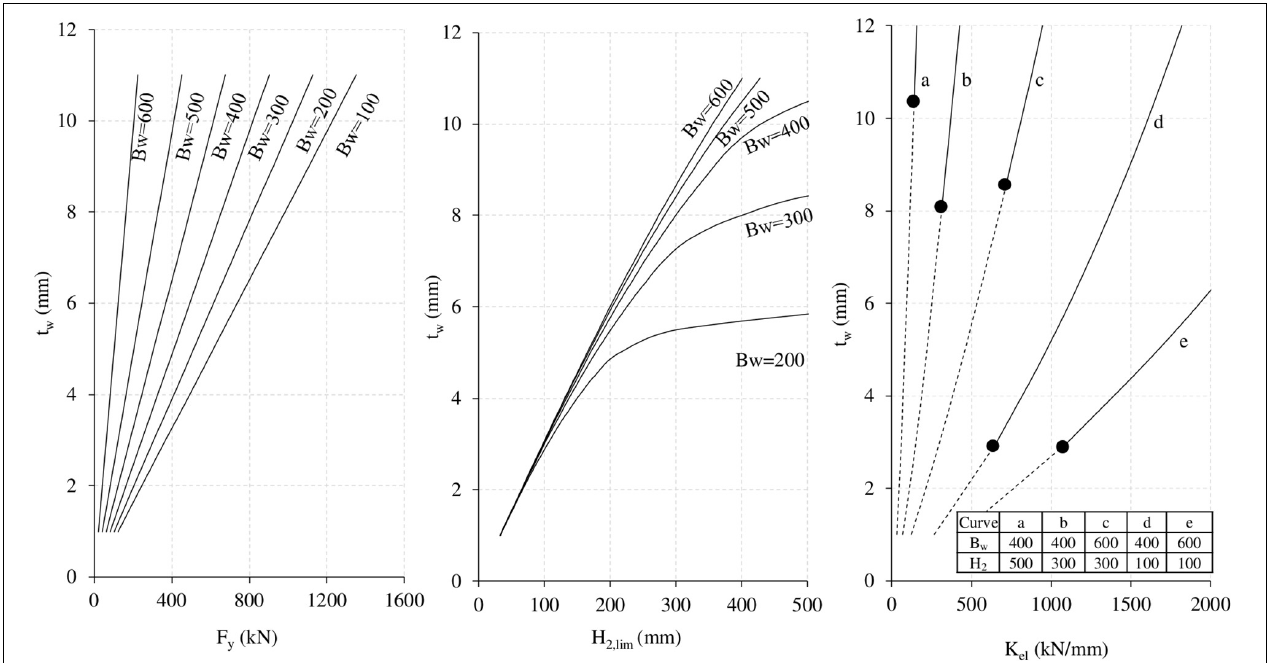
FIGURE 9 | Preliminary design chart of SL devices (S355 steel grade; B w and H 2 expressed in